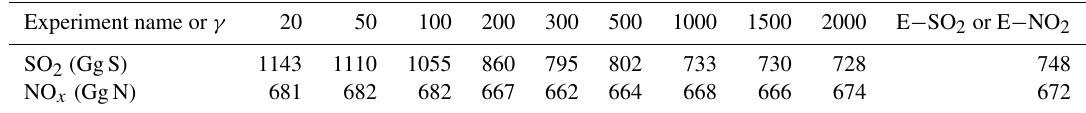
Table 3. Posterior anthropogenic emissions for October 2013 from E-joint, E-joint–d γ , E − SO 2 , and E − NO 2 . Experiment name or γ